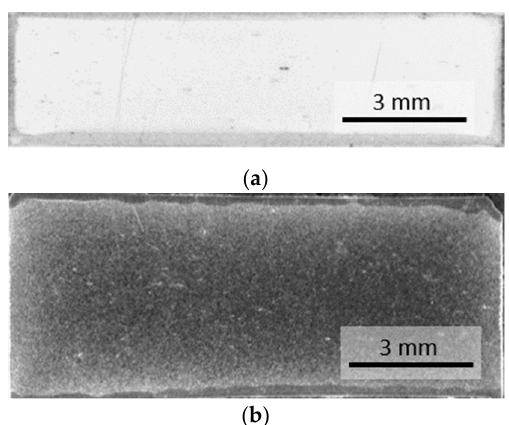
Figure 9. Porosity distribution in: ( a ) a conventional press and furnace sintered compact, and ( b ) a MF-ERS compact (8 kA-400 ms). The clearer areas, more reflecting zones, indicate a lower porosity.